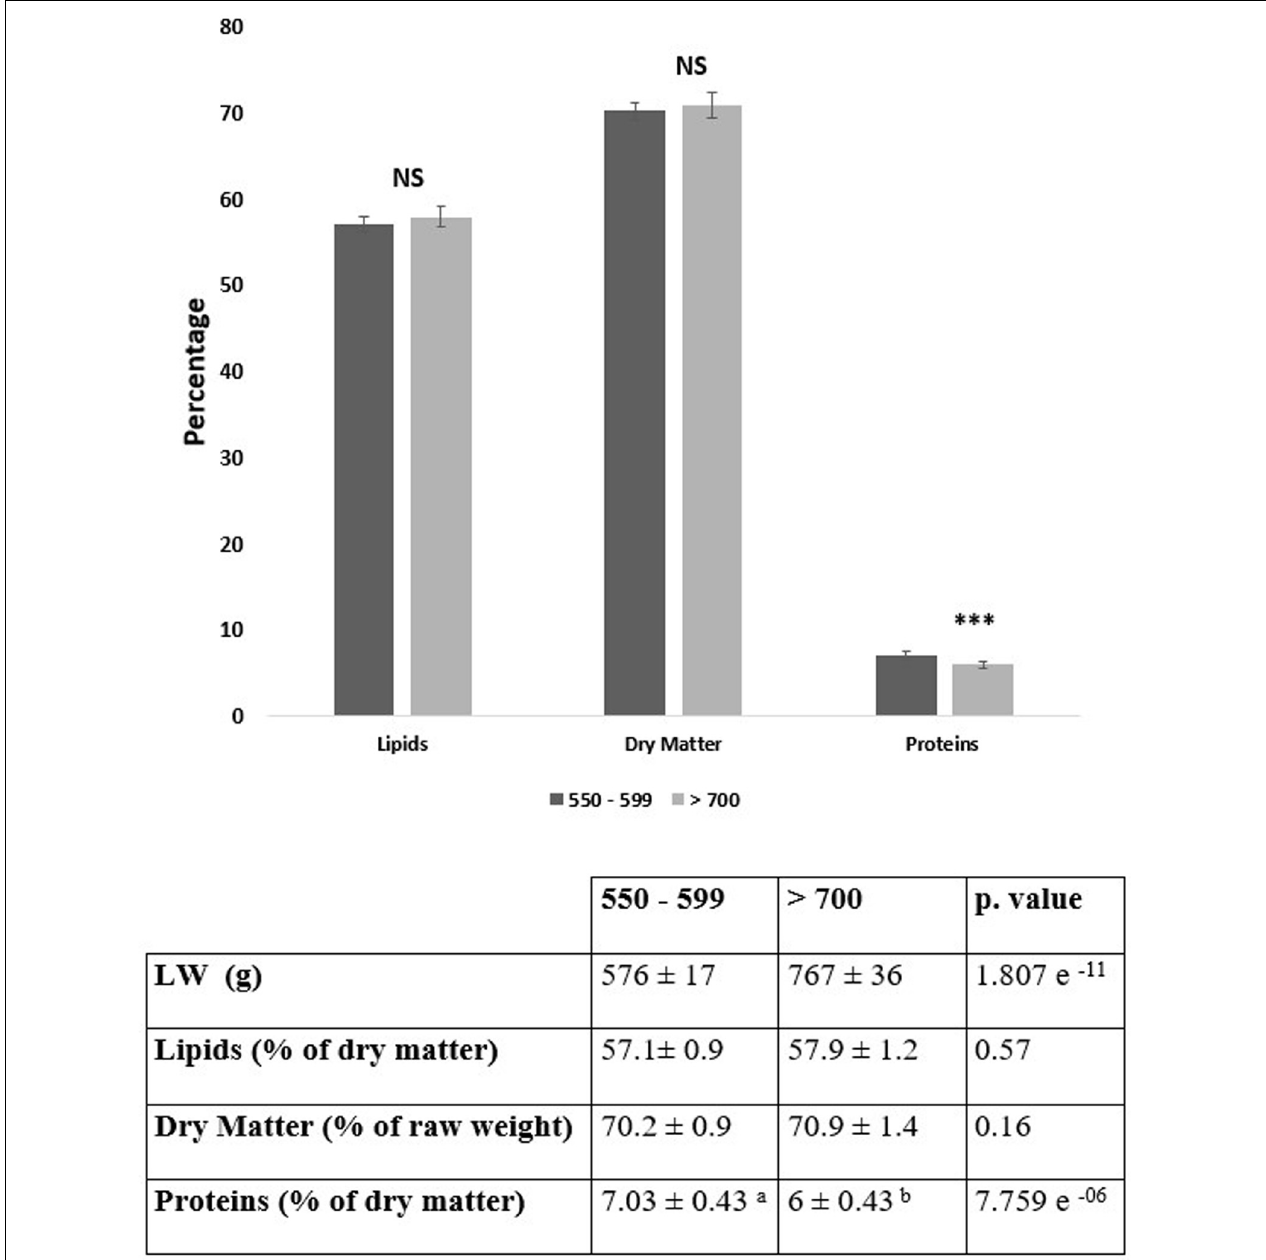
FIGURE 1 | Liver weights (LW) and gross chemical composition (lipids, dry matter, proteins) of livers from the two studied groups ( n = 12/groups), i.e., low weight livers (550–599 g) and high weight livers ( > 700 g). Values are means ± SD (* p ≤ 0.05, ** p ≤ 0.01, *** p ≤ 0.001 and NS = not